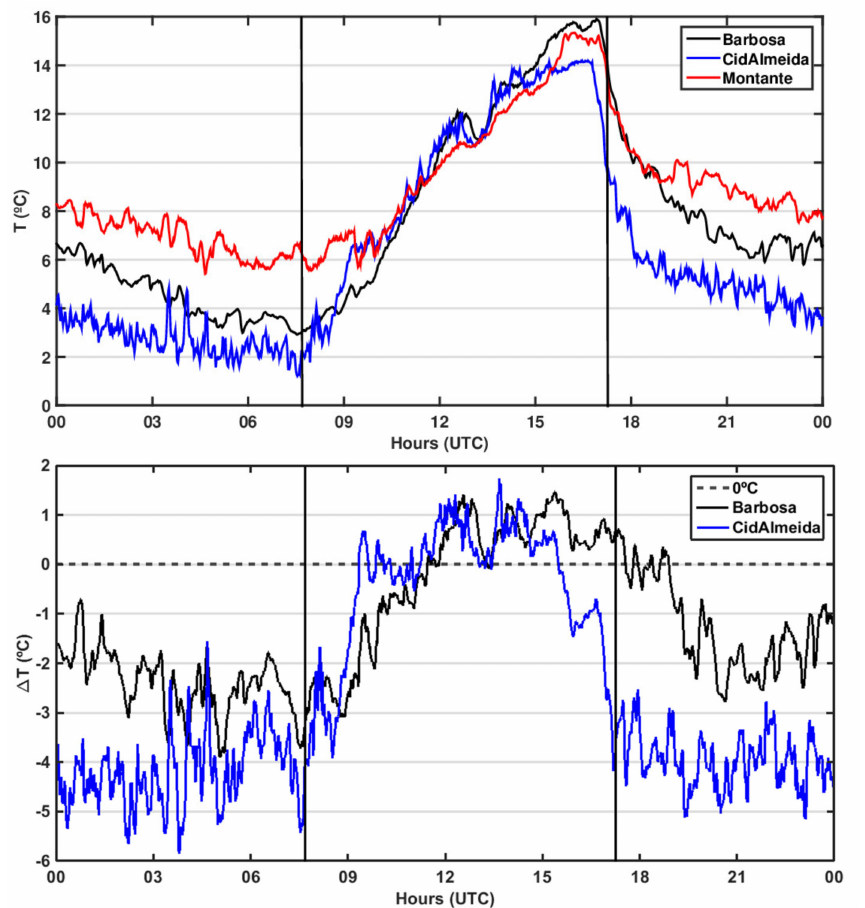
Figure 13. Air temperature in Alqueva ( upper panel ) and air temperature difference between shores and platform ( lower panel ) on 1 January 2019. Grey vertical lines indicate the sunrise and